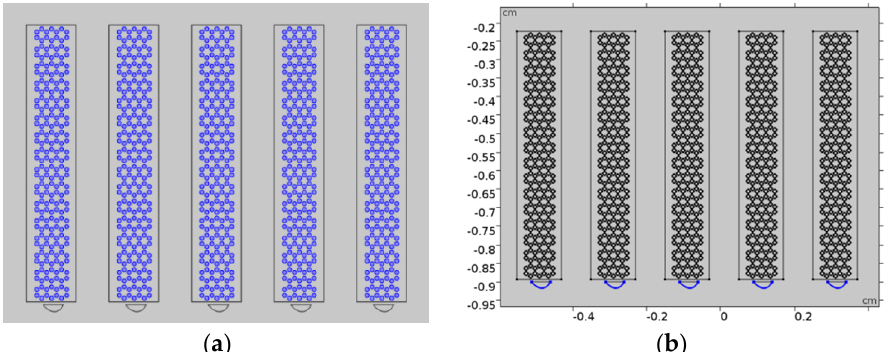
Figure 2. ( a ) Multi-channel breast ultrasound signal transmission model based on metamaterials; ( b ) parallel excitation source.